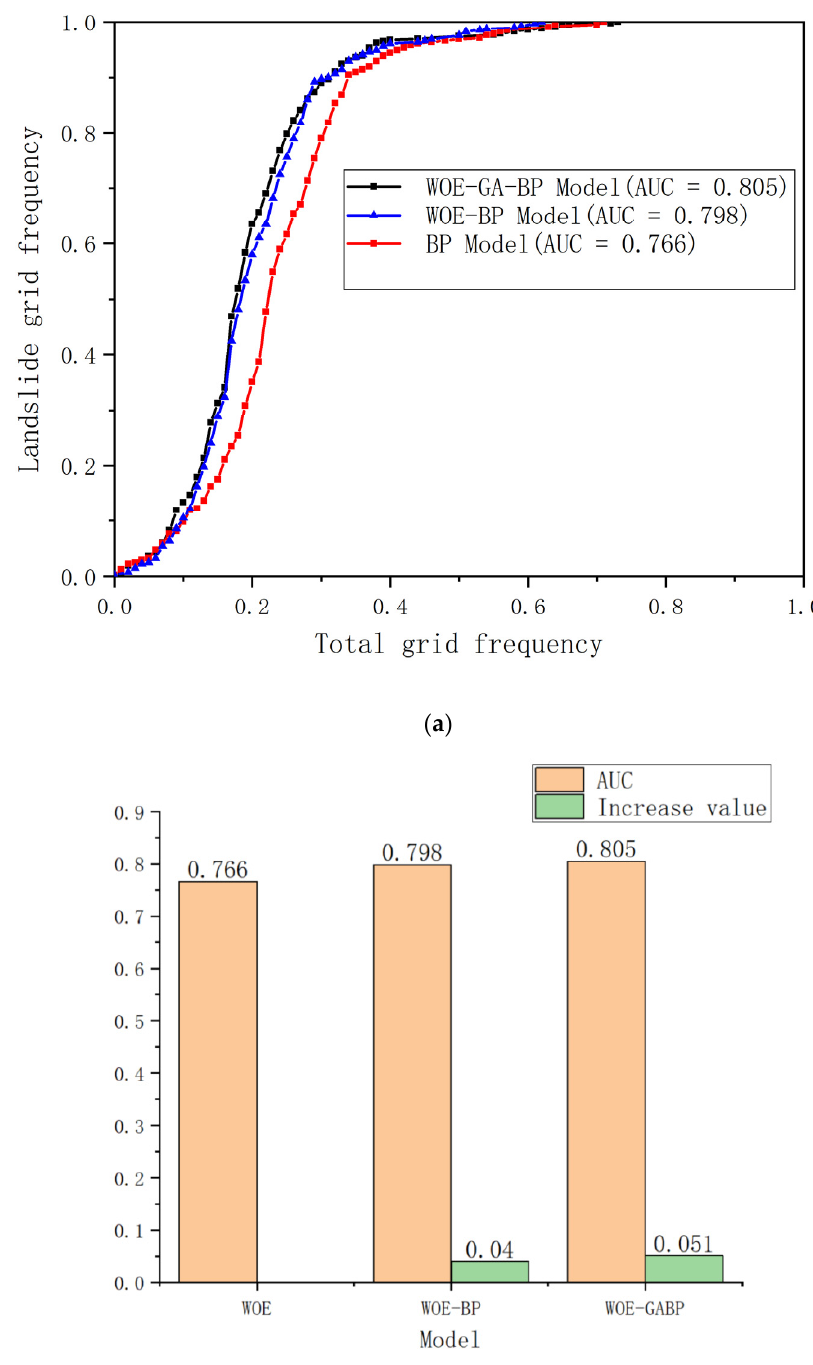
Figure 17. ( a ) ROC curve. ( b ) accuracy comparison chart. According to the ROC curve, the AUCs of the three models are 76.6%(WOE Model), 79.8%(WOE-BP Model), and 80.5%(WOE-GA-BP Mod); however, only the area corresponding to the WOE-GA-BP model exceeds 0.8, resulting in good evaluation accuracy, and indicating that the predictive evaluation ability of the WOE-GA-BP model is better than those of the WOE and WOE-BP models.